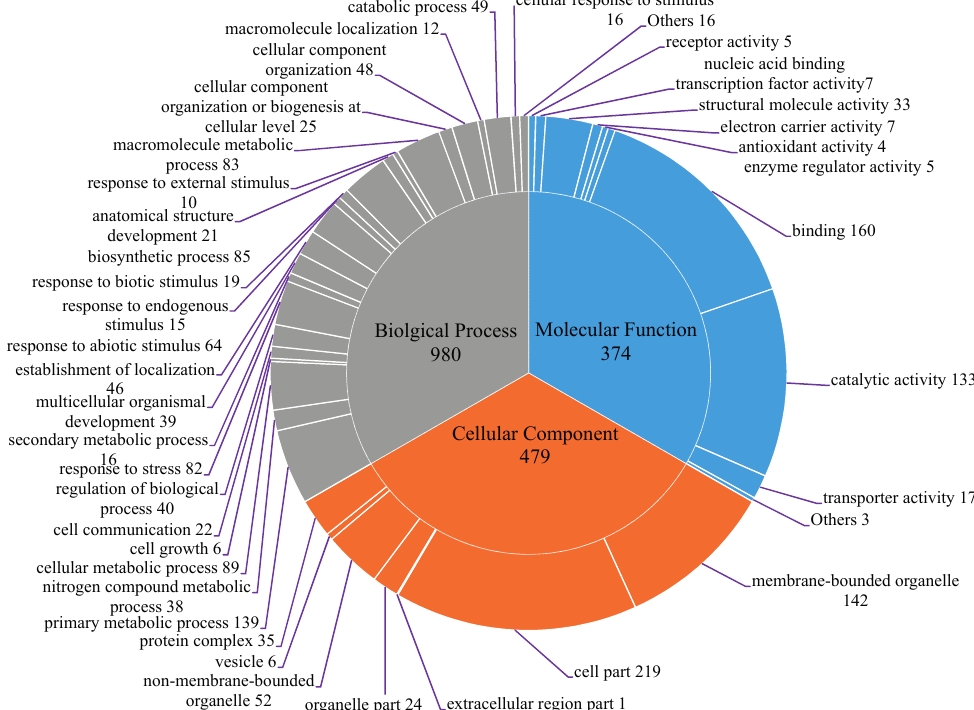
Figure 1. Gene ontology distribution of the L. gmelinii 634 EST-SSR unigenes into biological process, molecular function and cellular component. The number of transcripts encoded for each category is